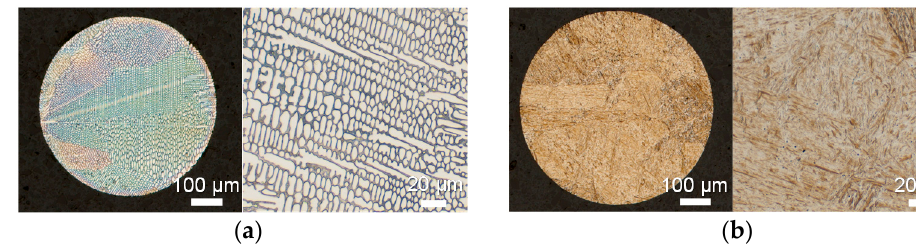
Figure 5. Micrographs of synthesized samples: ( a ) X210Cr12 and ( b ) 41Cr4.